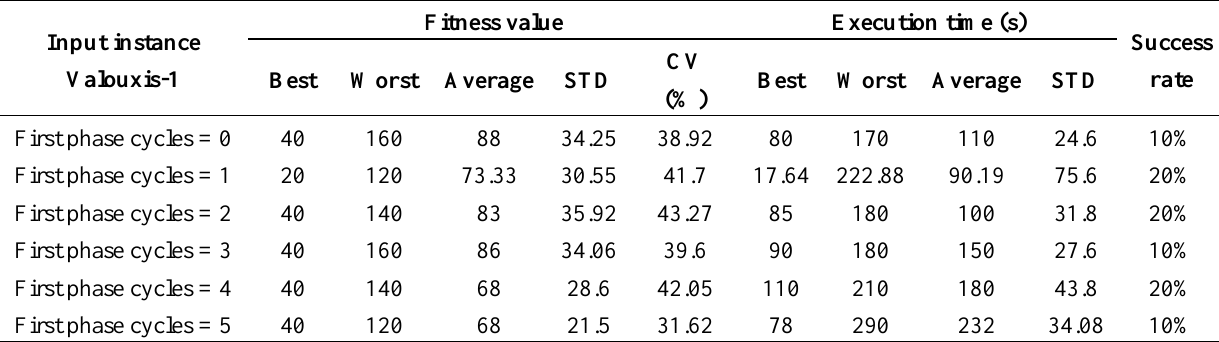
5. Investigating the effect of first phase’s number of cycles for input instance,